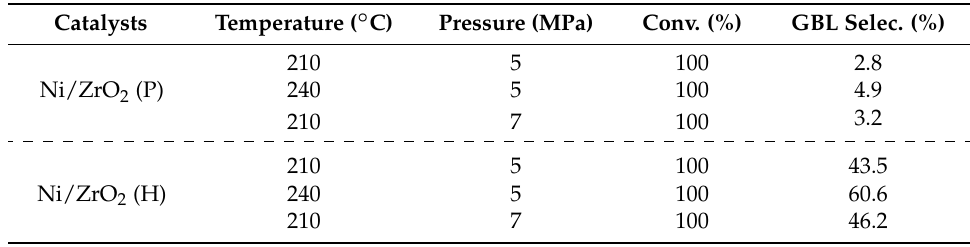
Table 4. MA conversion and GBL selectivity over the Ni/ZrO 2 (P) and Ni/ZrO 2 (H) catalysts under different temperature and pressure conditions for 480 min.